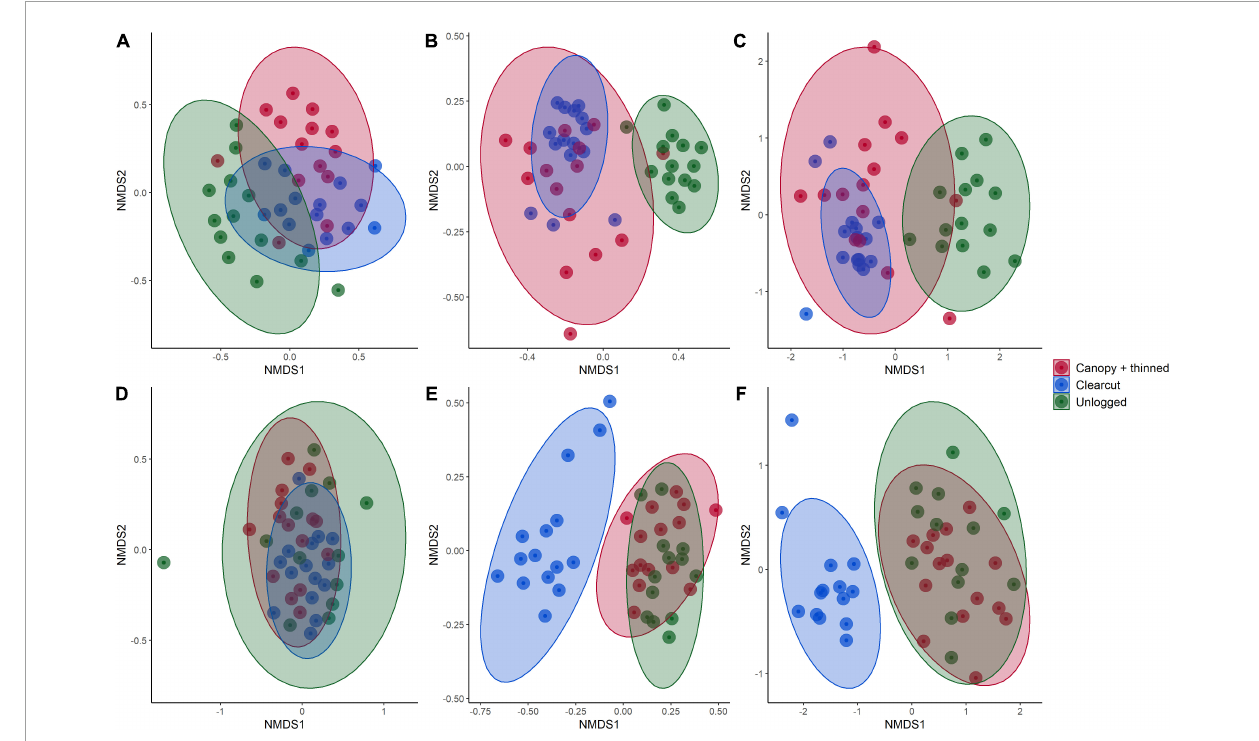
FIGURE2 Non-metric multidimensional scaling ordinations based on Bray-Curtis dissimilarity between three forest stands with different logging histories sampled in H. J. Andrews Forest, Oregon. Included are ectomycorrhizal fungi, saprotrophs, and plant pathogens in soils (A–C) , as well as ectomycorrhizal fungi, saprotrophs, and plant pathogens in litter (D–F) . All PERMANOVA p -values are < 0.001. Clearcut, watershed 6, canopy + thinned, watershed 7, unlogged, watershed